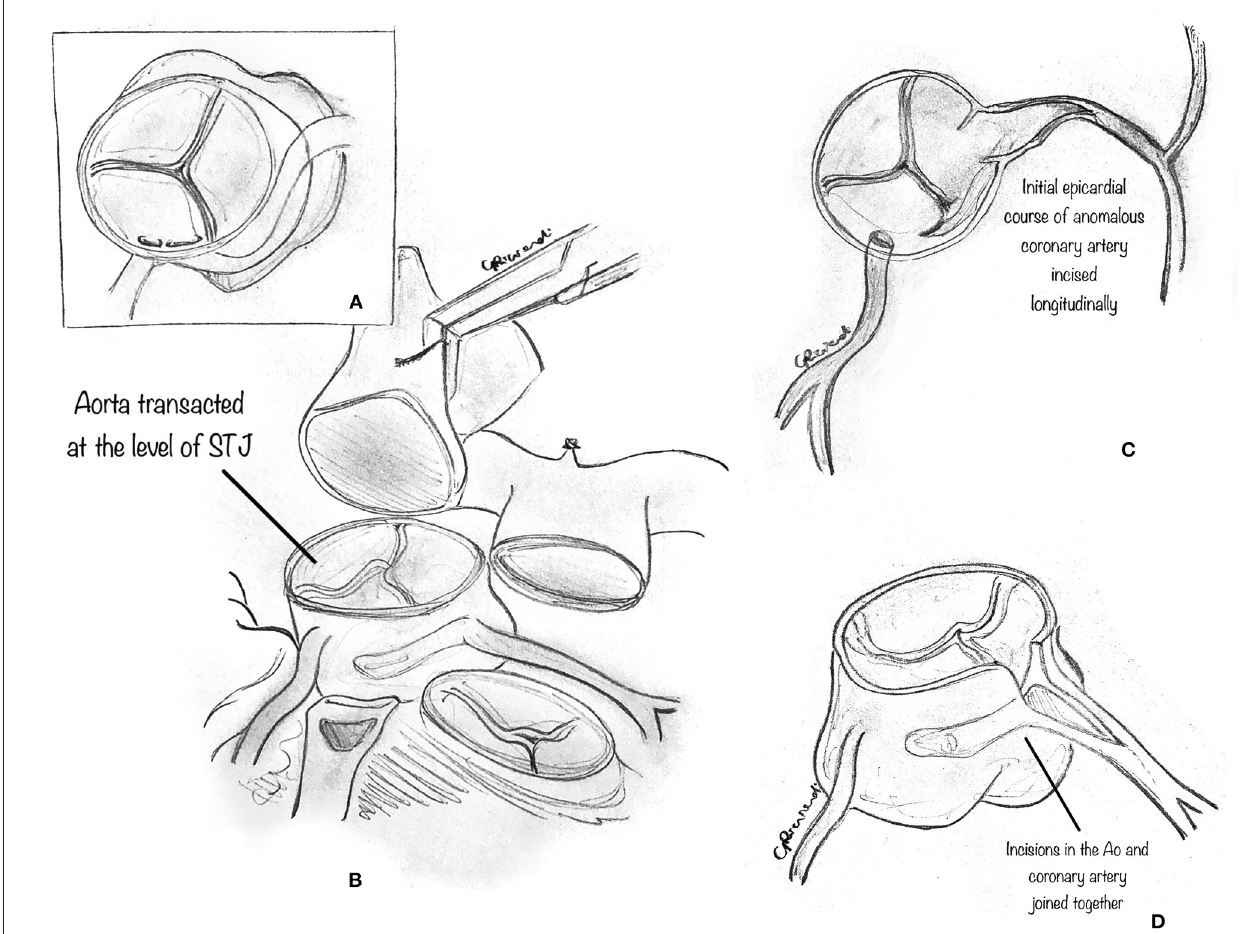
FIGURE 6 | Ostioplasty technique. (A) The diagram shows that the aortic and pulmonary roots are separated from each other down to the annular level, to expose the epicardial course of the anomalous coronary artery. (B) The normal epicardial course of the left coronary artery is identified and exposed by removing all surrounding connective tissue. The aorta is transected above the sinotubular junction. (C) The proximal epicardial course of the anomalous left coronary artery is incised longitudinally. (D) The ascending aorta is incised vertically in the left coronary sinus toward the coronary incision, beginning from the cut edge of the aorta. The two incisions, aortic and coronary, are joined at the point where the coronary artery leaves its intramural course to become epicardial.